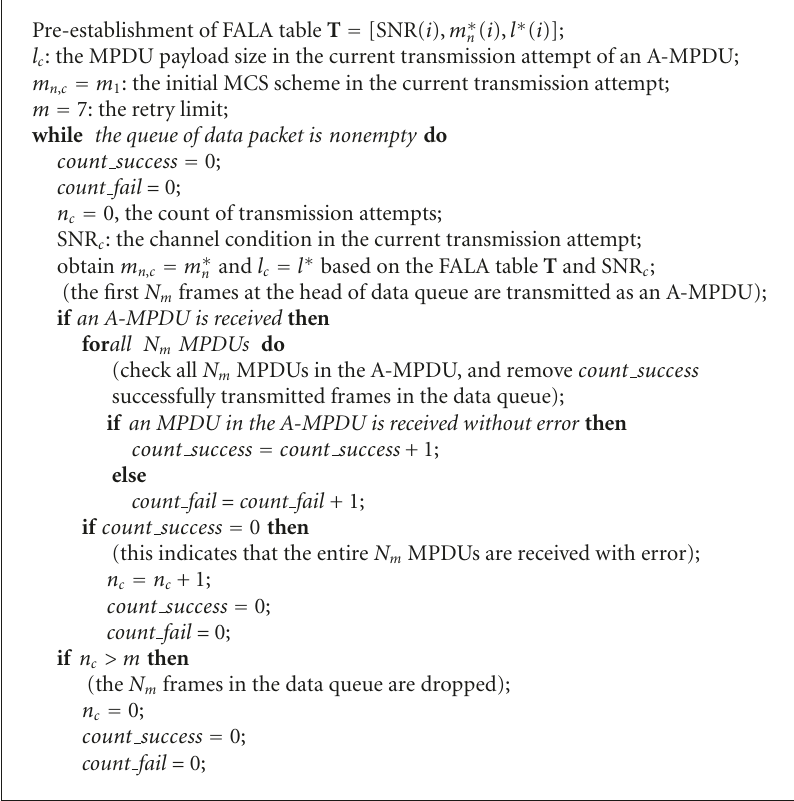
Pre-establishment of FALA table T = [SNR( i ), m ∗